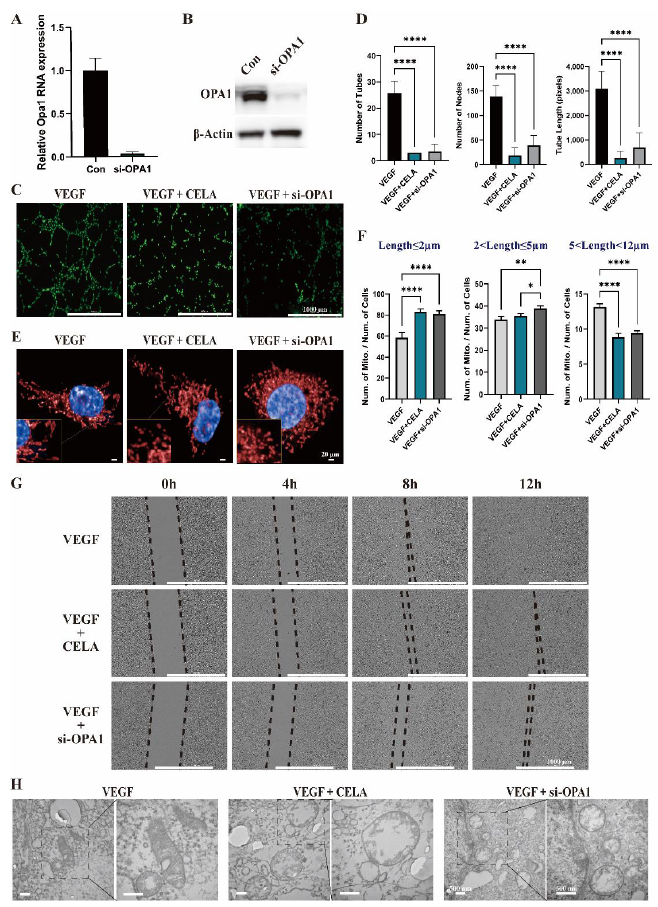
Figure 4. Celastrol inhibits angiogenesis by downregulating mitochondrial fusion protein OPA1. ( A , B ) Validation of siRNA knockdown OPA1 by qPCR and Western blot. ( C ) The effects of celastrol on Mat- rigel tube formation in HUVECs and OPA1 knockdown HUVECs. ( D ) The effects of celastrol on the nodes of tubes, the number of tubes, and tube length in HUVECs and OPA1 knockdown HUVECs. ( E , F ) The effects of celastrol on mitochondrial length in HUVECs and OPA1 knockdown HUVECs evaluated by high-content screening. ( G ) The wound-healing migration assay showed the effects of celastrol on the migration capacity of HUVECs and OPA1 knockdown HUVECs. ( H ) The changes of mitochondrial structure of HUVECs in the celastrol group and OPA1 siRNA group under TEM. * p < 0.05, ** p < 0.01, **** p < 0.0001.